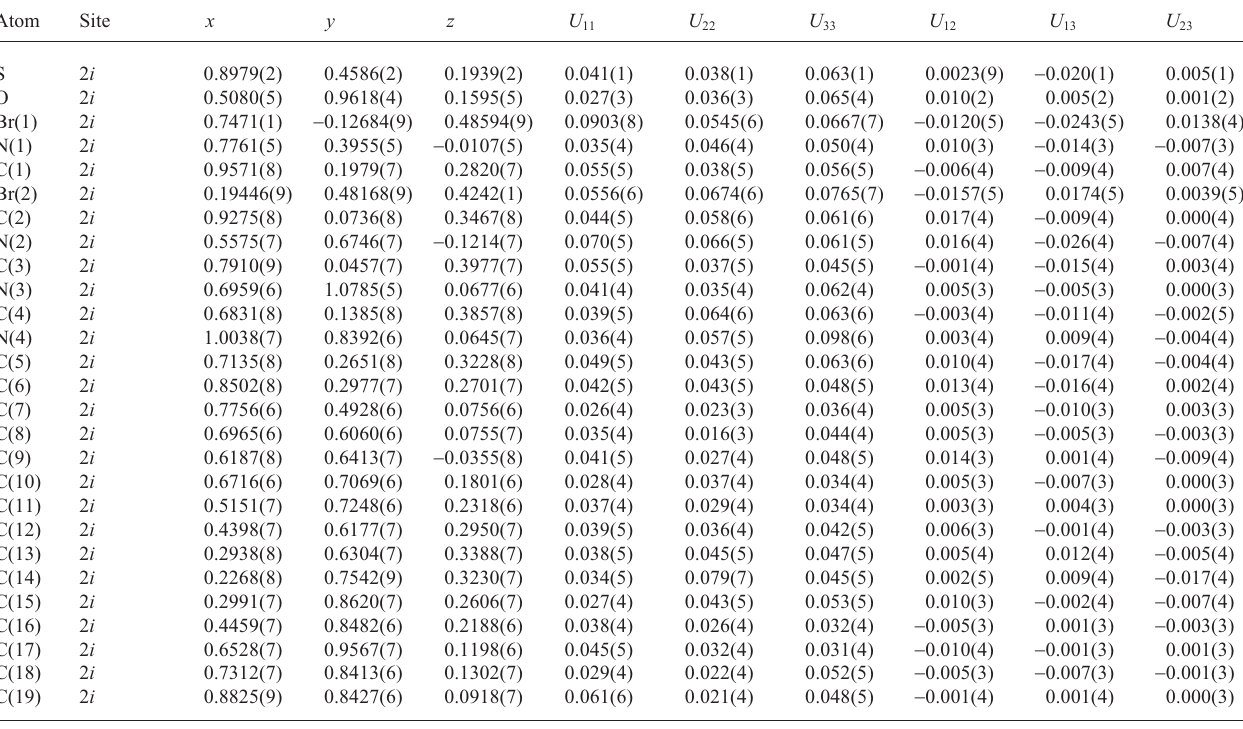
Table 3. Atomic coordinates and displacement parameters (in Å 2 )